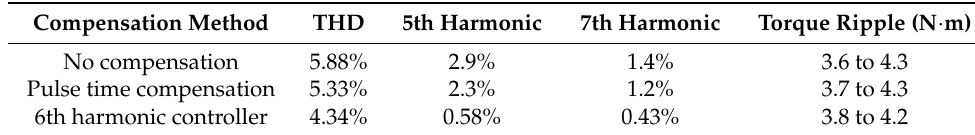
Figure 18. Simulation results under 6th harmonic controller. ( a ) i as ; ( b ) FFT; and ( c ) output torque. Table 3. Comparison of the simulation results.